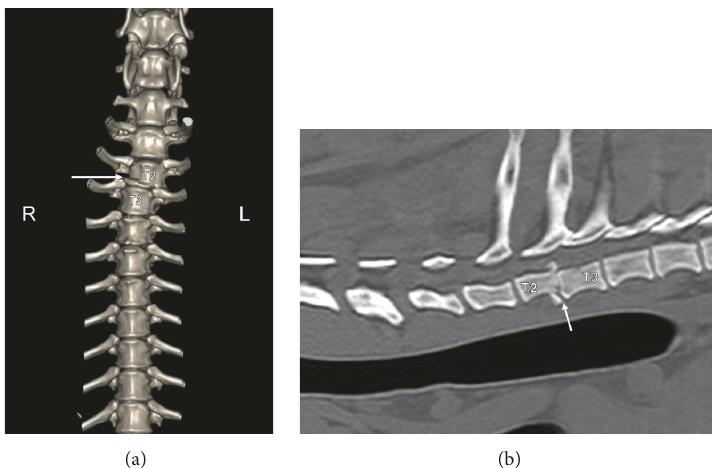
Figure 2: (a) Three-dimensional reconstruction of the preoperative computed tomographic imaging. Imaging of the cranial thoracic spine that shows right lateraldisplacement of the caudal spine at the levelof T2 and T3 vertebrae.The white arrow denotes caudal end plate fracture of T2. (b) Preoperative Computer Tomographic imaging of the cranial thoracic spine at the level of the spinal subluxation. The caudal end plate fracture of T2 is noted (white arrow).